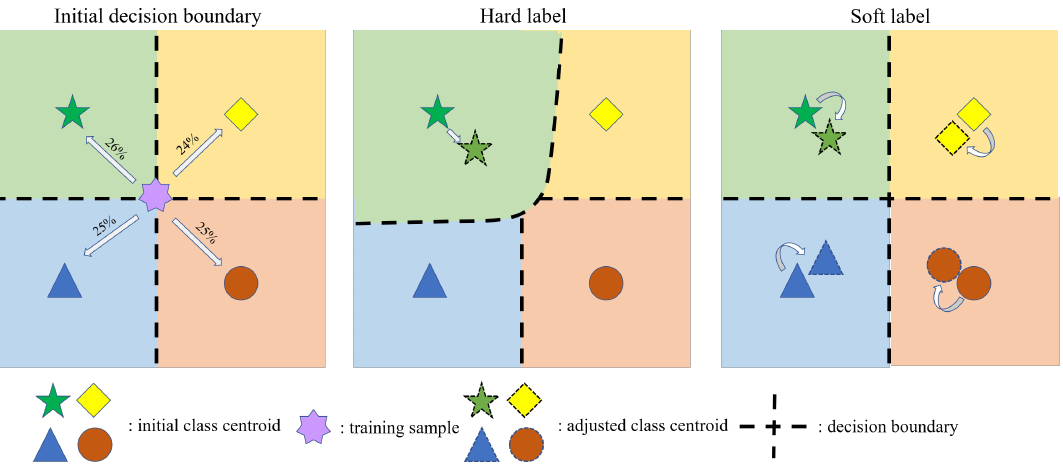
Figure 1. Unreliable training samples and its influence on decision